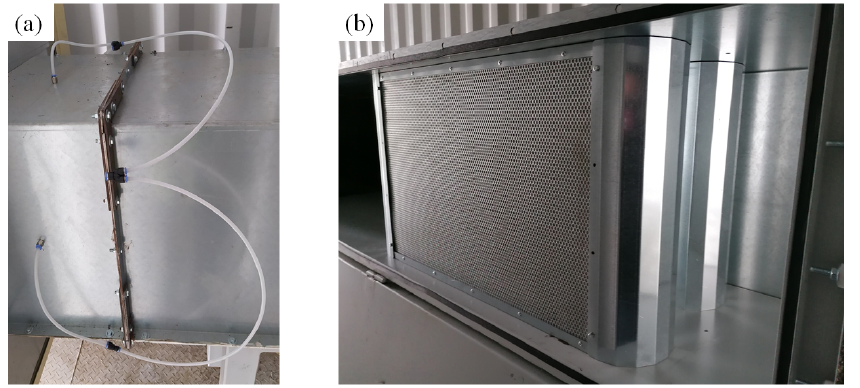
Figure 4. ( a ) Sampling probes for the pressure in the walls of the duct, ( b ) position of the splitter silencers in the duct.